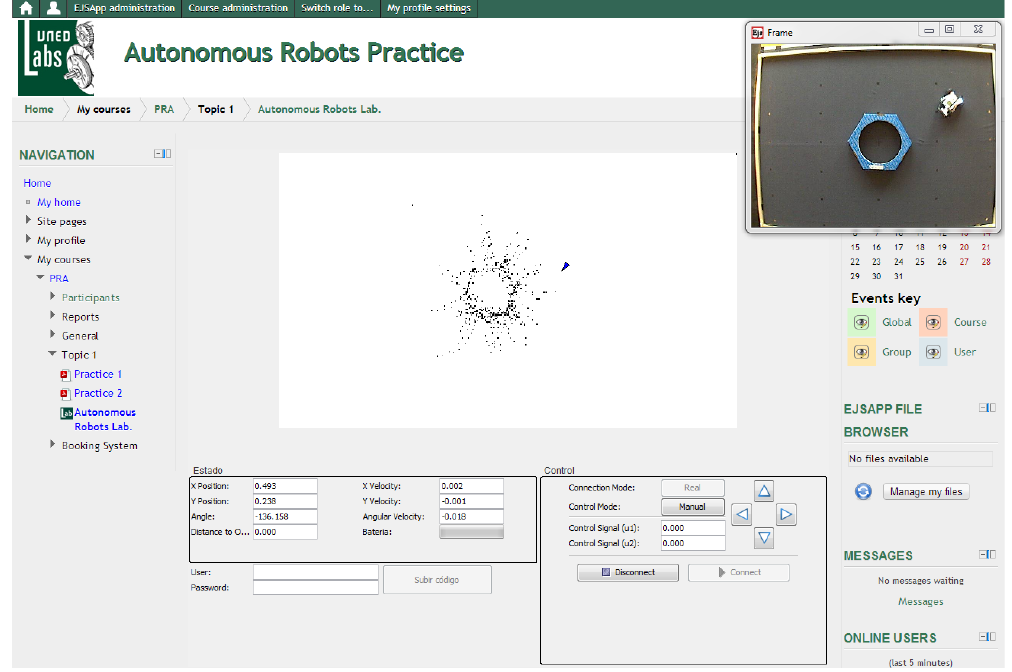
Figure 10. Example of a real experiment performed by a